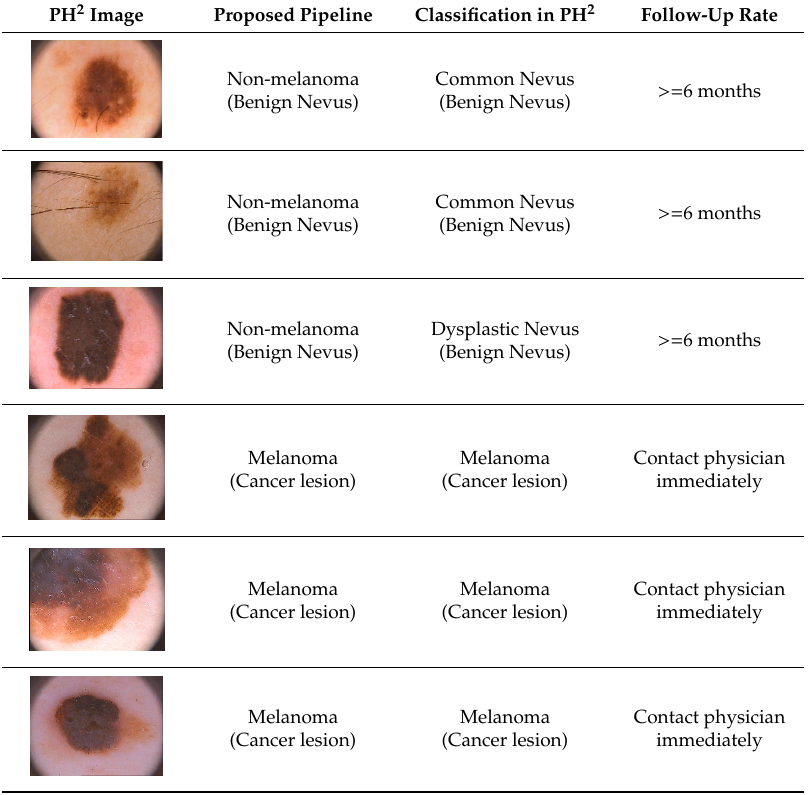
Table 3. Classified nevus versus classification made by the proposed pipeline.